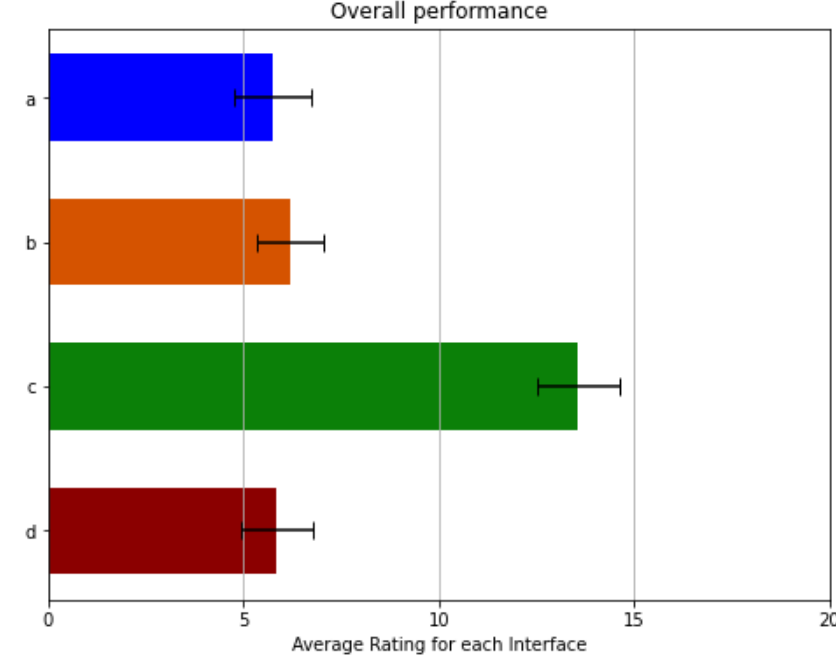
Figure 13. Overall performance of the different versions. ( a ) is the sEMG PR iteration; ( b ) is the one with the buttons; ( c ) uses the computer vision algorithms; and ( d ) is the interface utilizing a reduced contractions subset.